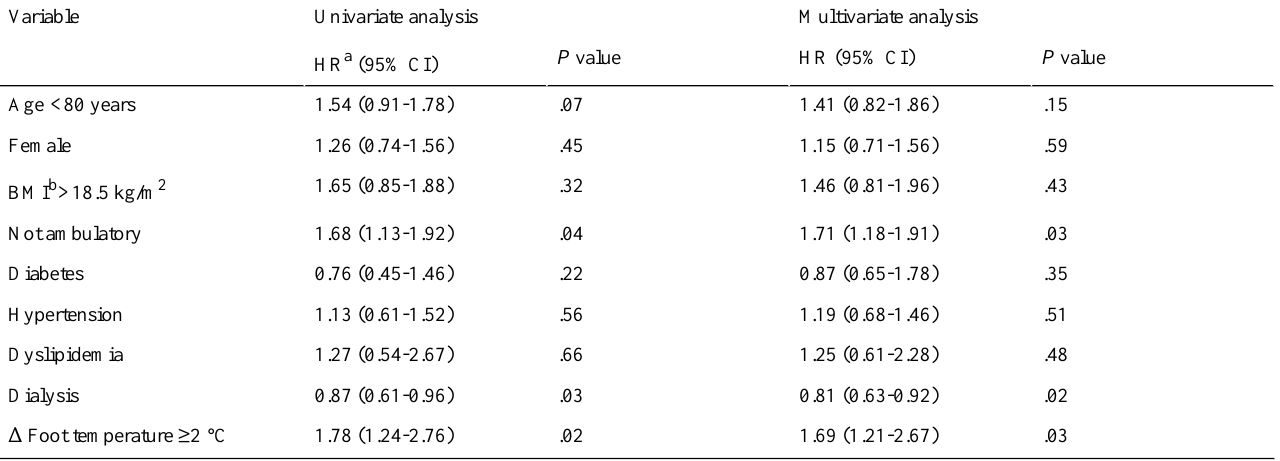
Table 2. Univariate and multivariate analyses: predictors of wound healing at 180 days after endovascular therapy.